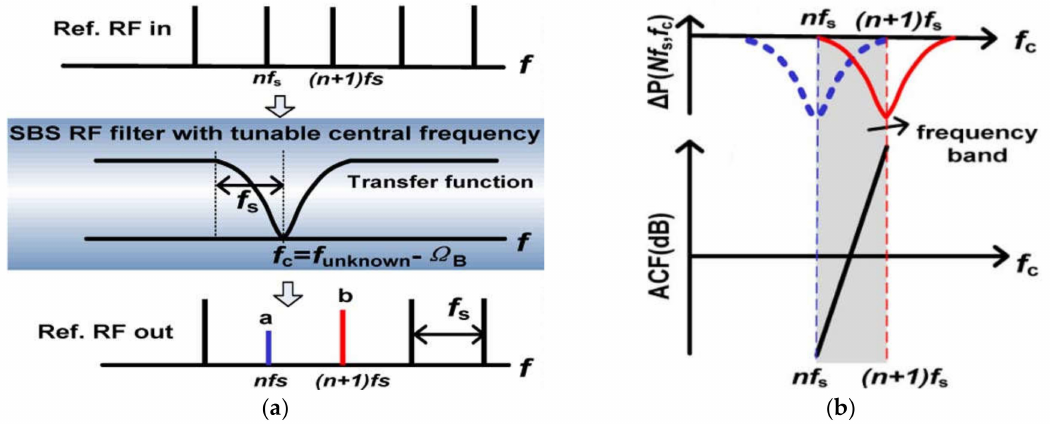
Figure 23. ( a ) Conceptual diagram of a SBS-based IFM system; ( b ) analytical relationship between the unknown RF and the RF power change in each channel and the resulting mapping between the ACF and the unknown RF